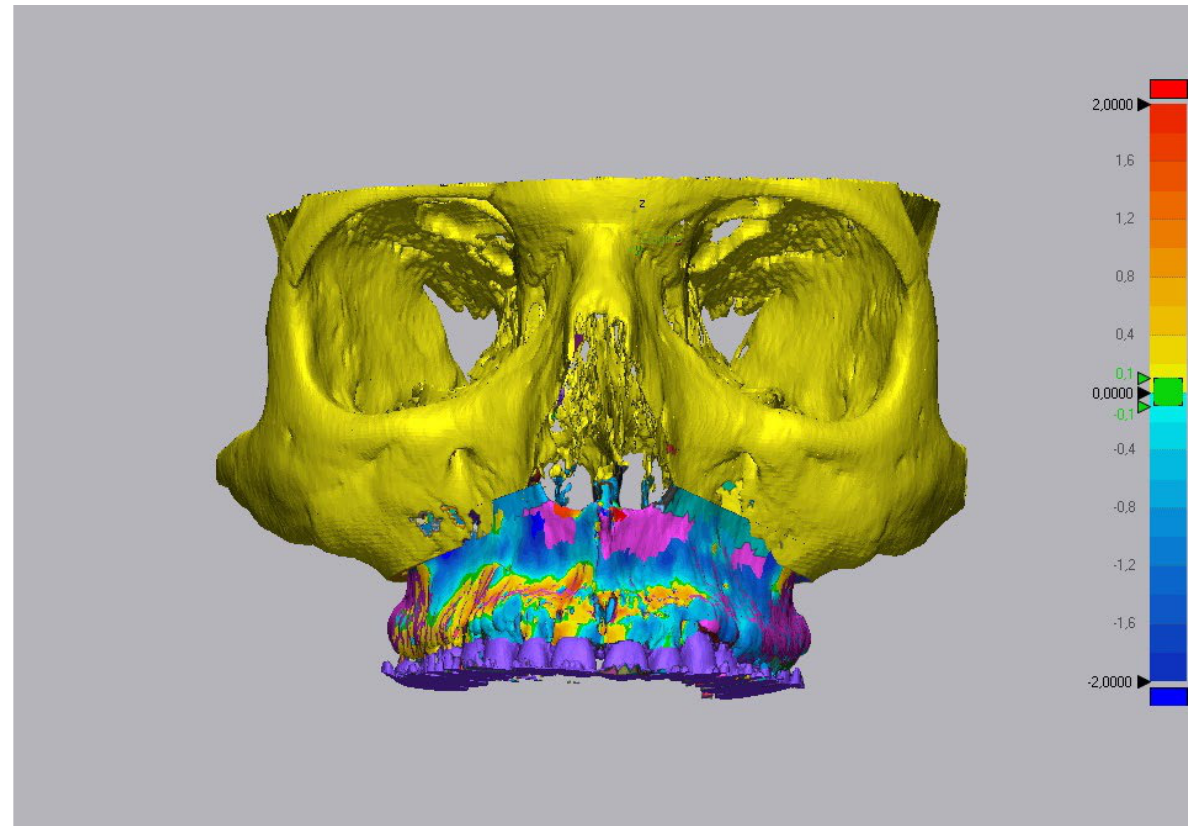
Figure 5. Three-dimensional comparison of the meshes in ROI2, highlighted by colormap.